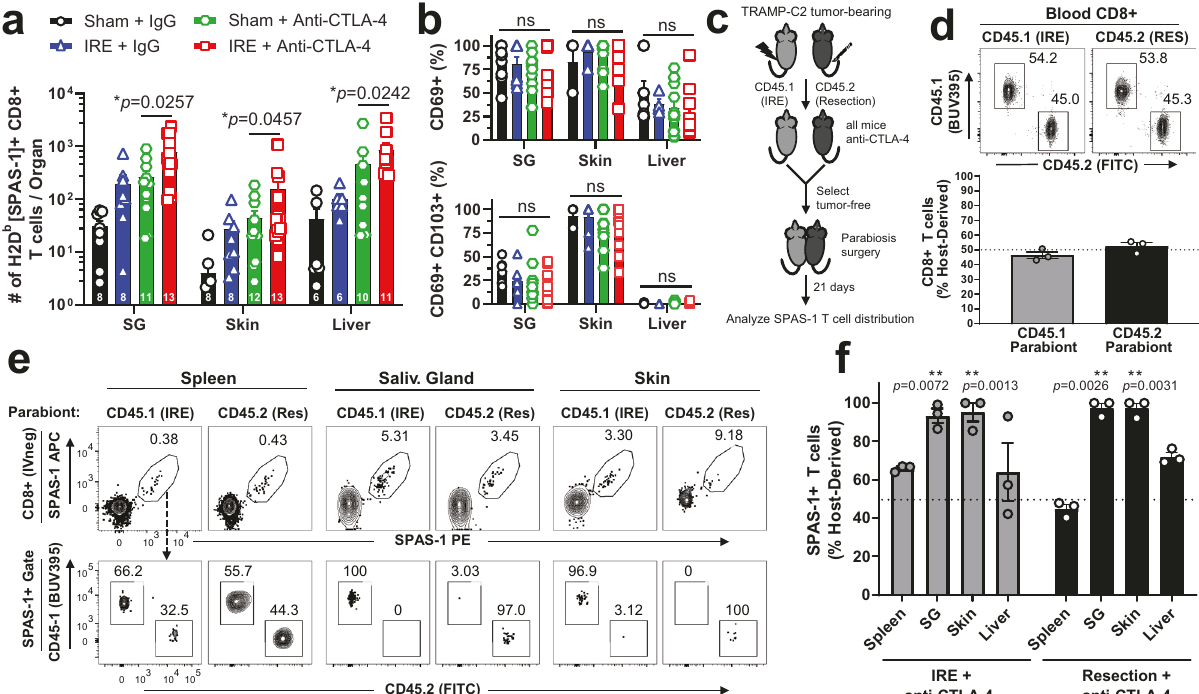
Fig. 7 Combination therapy is associated with increased numbers of tissue-resident memory SPAS-1 + T cells in non-lymphoid tissues. Mice bearing TRAMP-C2 tumors were treated as in Fig. 4. a 21 days following therapy, the number of SPAS-1 + T cells was quanti fi ed by fl ow cytometry from the indicated tissues. b Percentage of SPAS-1 + T cells identi fi ed in ( a ) that express CD69 (top panel) or CD69 and CD103 (bottom panel). Data in ( a , b ) represent individual mice ( n = 8 – 13/group) pooled from four independent experiments, with exact n for each group shown at the base of each bar for each tissue. The exact n values for the number of samples analyzed in ( b ) are shown in the Source Data File. c TRAMP-C2 tumors were inoculated i.d. into CD45.1 and CD45.2 mice and tumors were removed by IRE or surgical resection, respectively, followed by anti-CTLA-4, every third day for four total doses. Mice that cleared tumors were selected and rested for three additional weeks, and parabiosis surgery was performed. d Flow cytometry of blood collected from each partner mouse 17 days after surgery, showing the fraction of host-derived total CD8 + cells from each parabiont in a representative FACS plot (top) and quanti fi ed for 3 pairs of mice (bottom). e After 21 days of equilibration, mice in each pair were individually injected i.v. with 3 µ g of FITC-labeled anti-CD8 α antibody 3 min prior to harvest, to mark CD8 + T cells in the circulation. Single-cell suspensions from the indicated organs were prepared and stained for fl ow cytometry. Top row, SPAS-1 + T cell gating from the IV-CD8 + T cell population from the indicated organs of each congenically distinct partner is shown. Bottom row, SPAS-1 + T cells from each partner are discriminated by CD45.1 and CD45.2 to determine the partner of origin. f Quanti fi cation of data from 3 parabiotic pairs, separated by treatment group. The proportion of SPAS-1 + T cells in each tissue that were derived from the host mouse is presented as a fraction of the total from both host and donor mice. a – b Data pooled from four independent experiments. Unpaired two-tailed Mann – Whitney test was performed; * p < 0.05. c – f Data representative of one experiment with 3 parabiotic pairs. One sample T test with a hypothetical value of 50 was performed; ns, not signi fi cant; ** p < 0.01. All bars represent mean ± S.E.M. SG salivary gland. Source data are provided as a Source Data